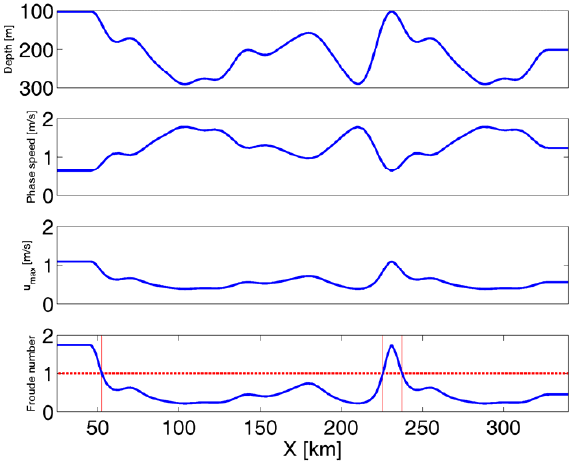
Figure 8. The Froude number and other characteristic quantities against the distance at the defined area of the Sea.